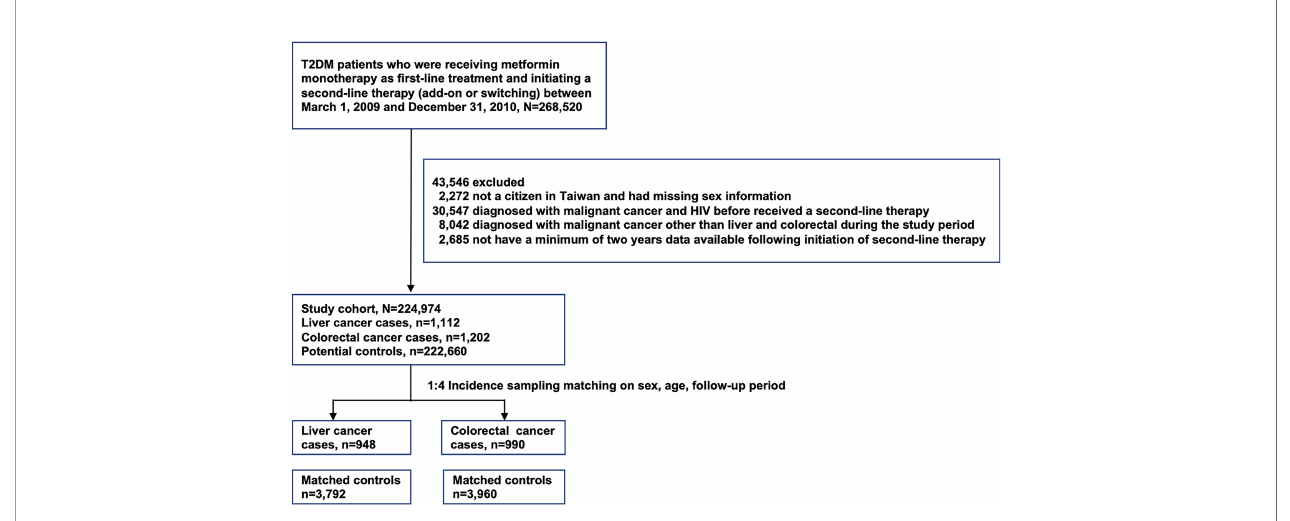
FIGURE 1 | Flowchart of enrollment of patients with T2DM.